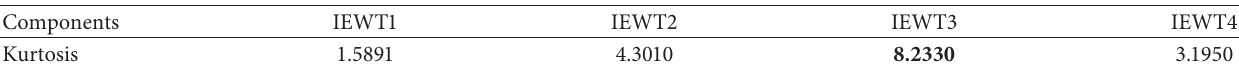
Table 2: Kurtosis of IEWT